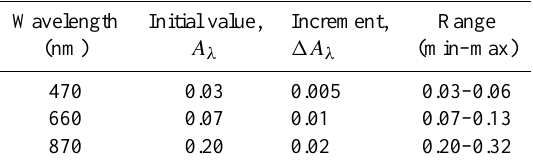
Table 2. Initial values, increments and the corresponding ranges of assumed surface albedo as functions of wavelengths.